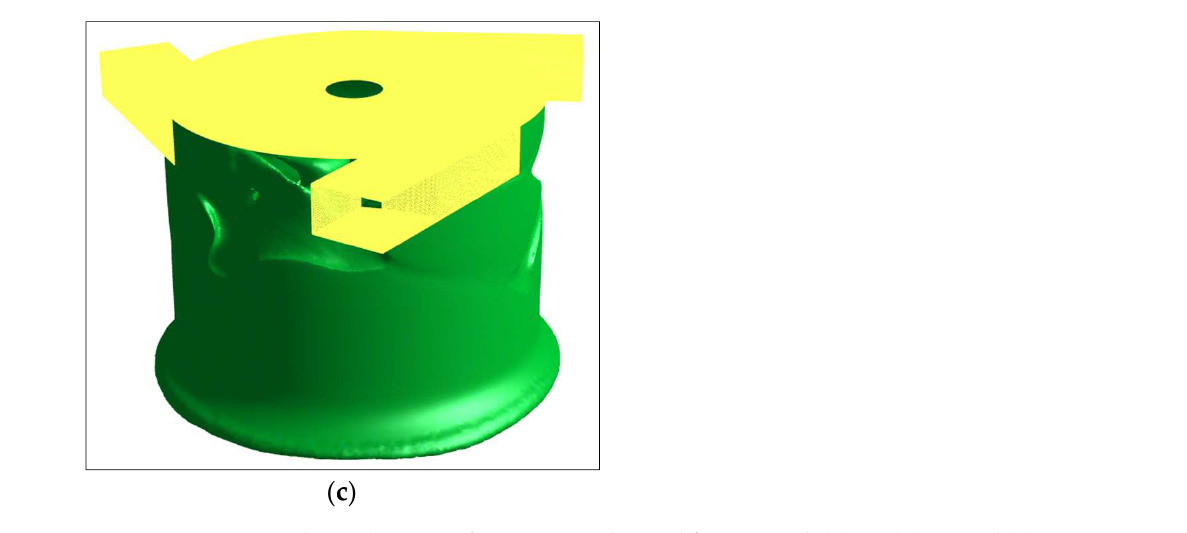
Figure 15. Mach number isosurface at M = 1 obtained for SVT with ( a ) air ; ( b ) He ; and ( c ) CO 2 . An increase in the Reynolds number changed the structure of streamlines in considered SVTs (Figure 16). It is expressed by the increase of the velocity magnitude value and the increase of swirl diameter (the right black circle in Figure 16).